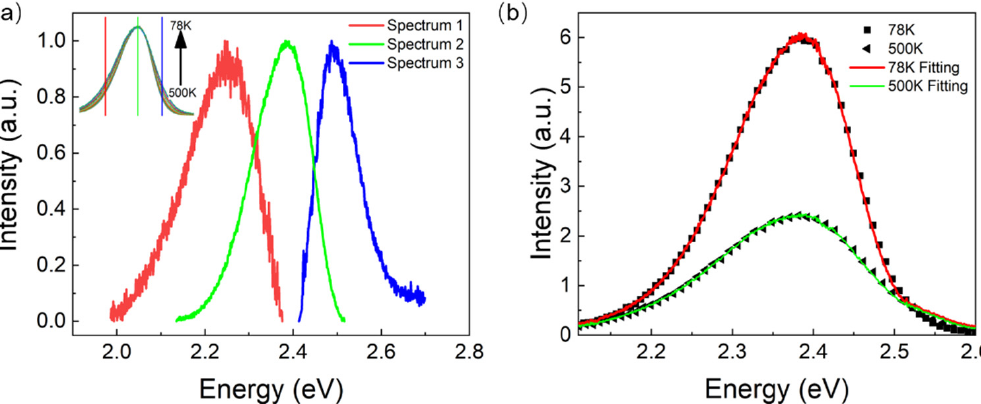
Figure 3. ( a ) Three resolved spectra extracted from the temperature-dependent PL spectra. The inset shows the normalized temperature-dependent spectra, and the solid lines with three colors indicate the three resolved normalized spectra. ( b ) The measured and fitted PL spectra at 78 K and 500 K, which is the linear combination of the three resolved spectra. The solid line shows the fitted curve.